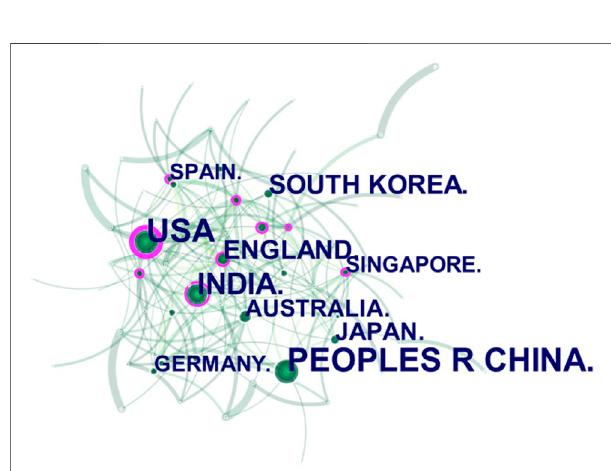
FIGURE 1 | Frame fl ow diagram showing the detailed selection criteria and bibliometric analysis steps for the study of the application of AI in the diagnosis of ophthalmic diseases.